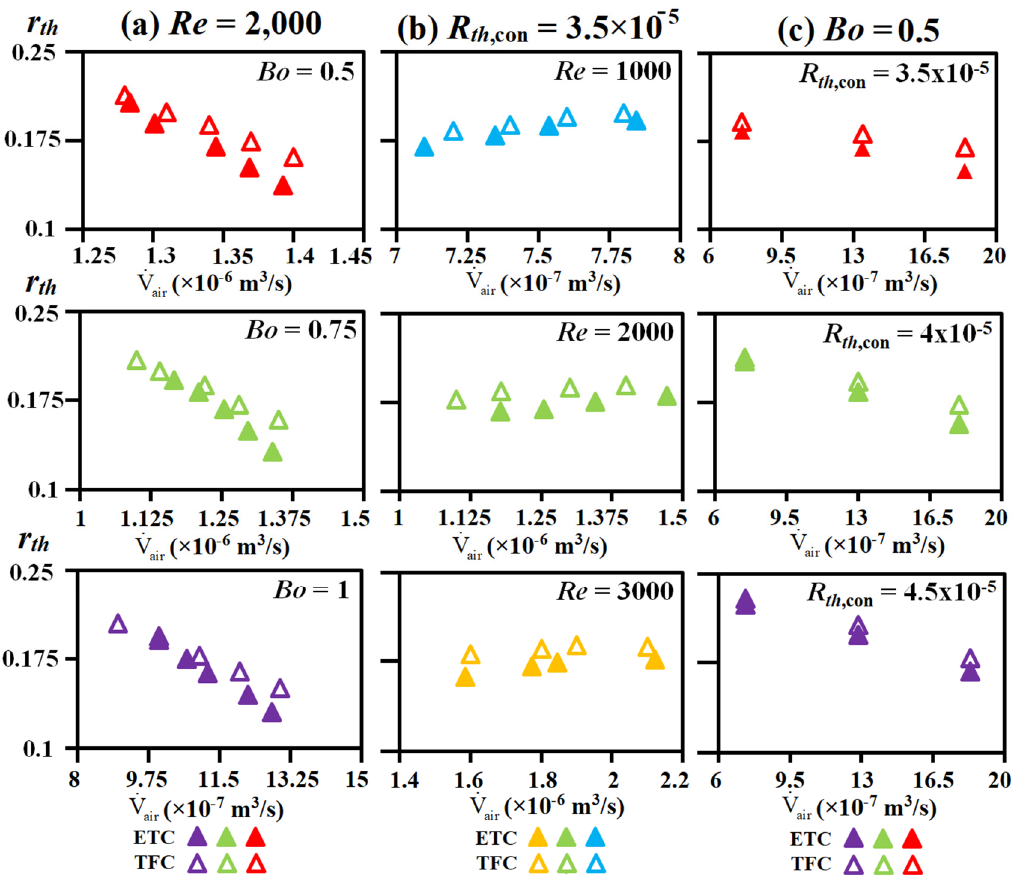
. V  for the loops with TFC and ETC at ( a ) Re = 2000. ( b ) R th ,con = V air for the loops with TFC and ETC at ( a ) Re = 2000. air